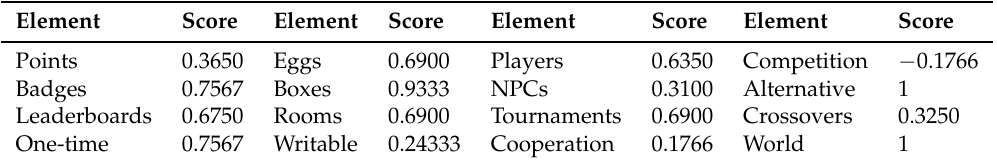
Table 14. Scores for the game elements (Source: